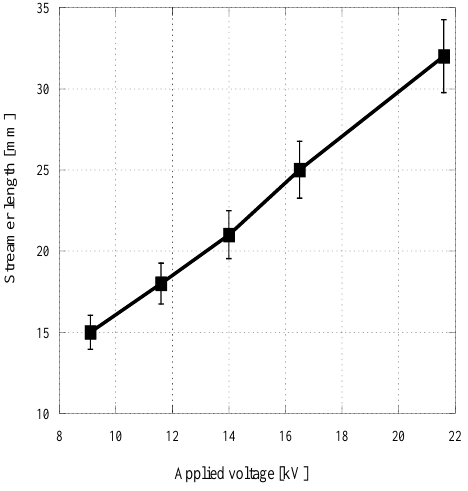
Figure 3. Variation of streamer length at water surface with applied pulse voltage.